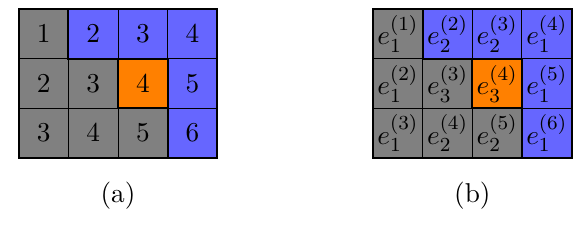
Figure 15 . Migrating cell and vector